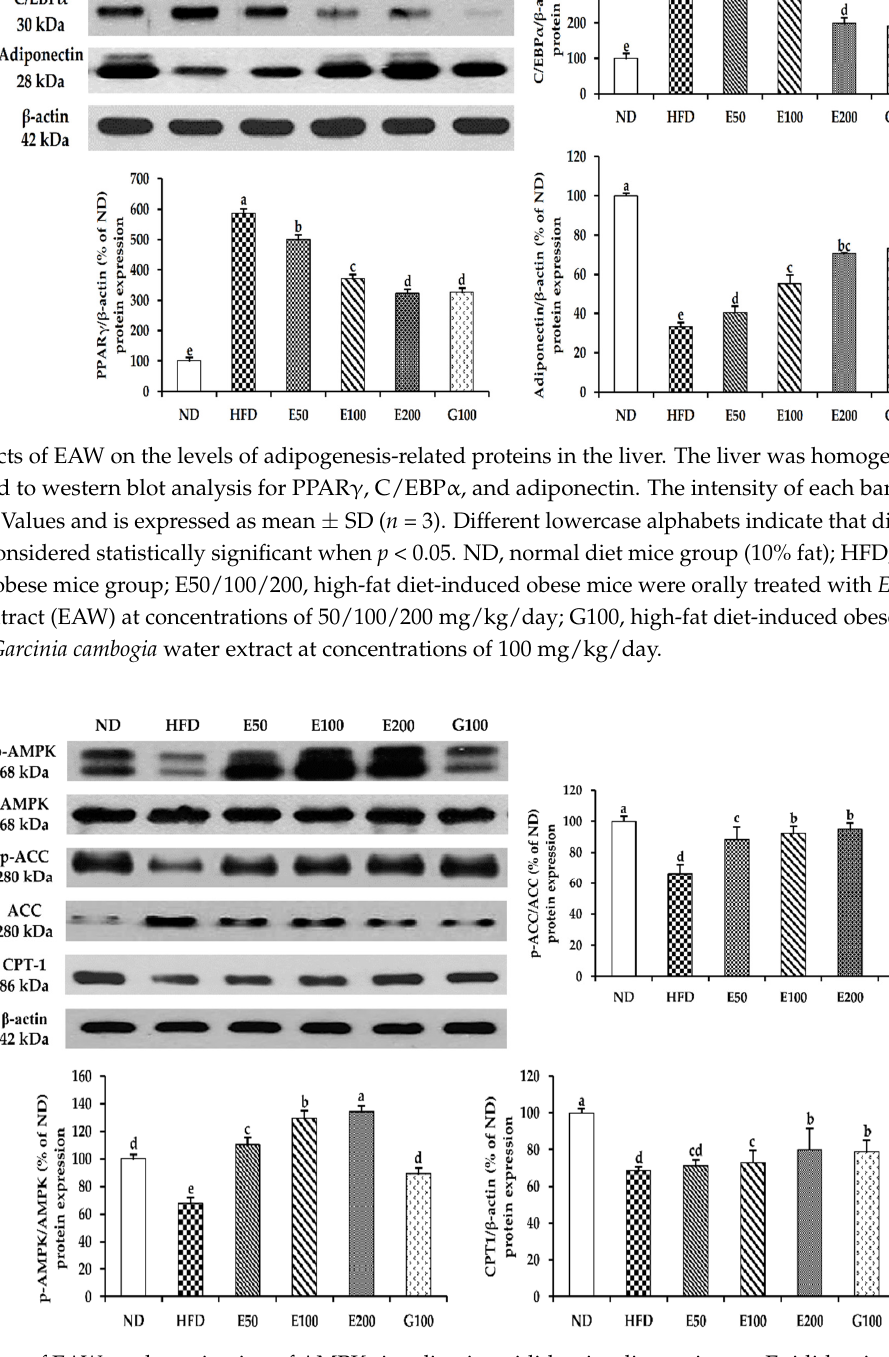
Figure 5. Effects of EAW on the activation of AMPK signaling in epididymis adipose tissues. Epididymis adipose tissue was homogenized, and the lysates were subjected to western blot analysis for p-AMPK, p-ACC, and CPT1. The intensity of each band was quantified using ImageJ. Values and is expressed as mean ± SD ( n = 3). Different lowercase alphabets indicate that differences between means were considered statistically significant when p < 0.05. ND, normal diet mice group (10% fat); HFD, high-fat (60% fat) diet-induced obese mice group; E50/100/200, high-fat diet-induced obese mice were orally treated with Erigeron annuus (L.) Pers. water extract (EAW) at concentrations of 50/100/200 mg/kg/day; G100, high-fat diet-induced obese mice were orally treated with Garcinia cambogia water extract at concentrations of 100 mg/kg/day.